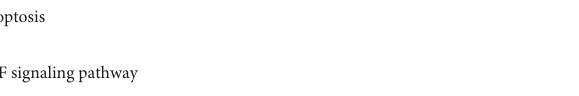
TABLE 2 Upregulated genes in TNF and apoptosis signaling pathways. Apoptosis BCL2, RELA, BIRC3, FADD, GADD45G, TNFRSF1A, NFKBIA, TNFRSF10B, CAPN2, TUBA1C, IL3RA, CTSH, FOS, CASP6, CASP7, TNFRSF10A, PARP4 TNF signaling pathway